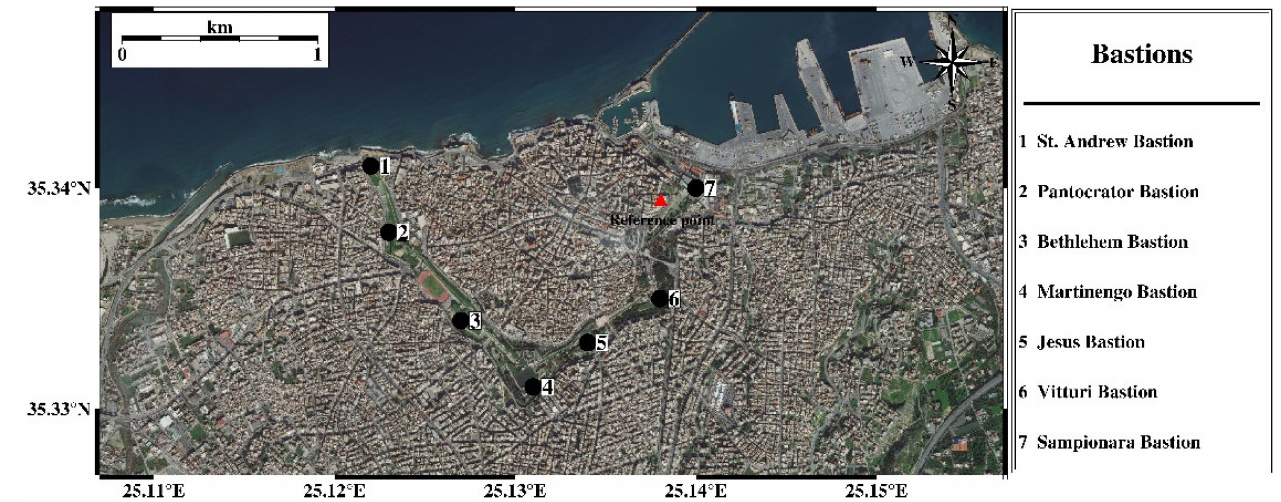
Figure 2. The Heraklion City Wall and its seven bastions. Red triangle represents the location of the reference